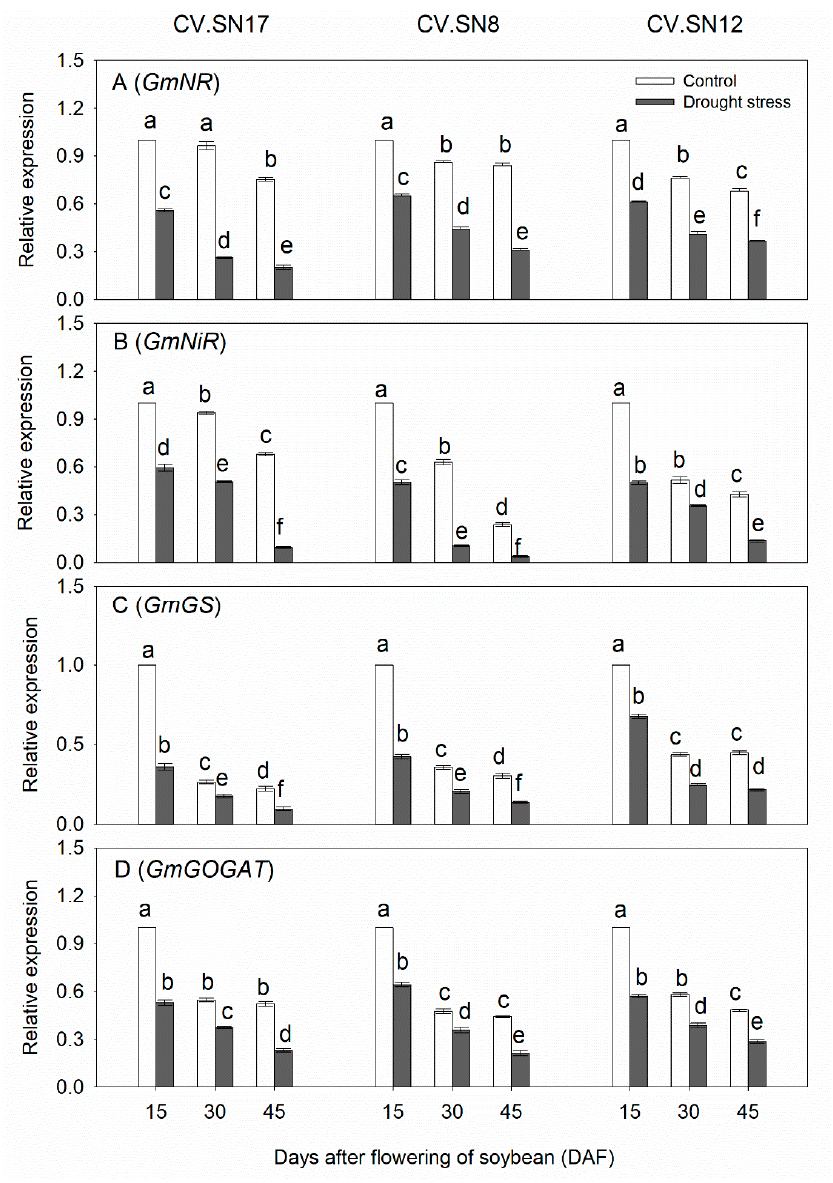
Figure 4. Changes of expression patterns of ( A ) GmNR , ( B ) GmNiR , ( C ) GmGS , and ( D ) GmGOGAT in leaves of CV.SN17, CV.SN8 and CV.SN12 under control and drought stress conditions. Data show the means ± standard deviation of three independent samples. Di ff erent letters above vertical bars indicate significant di ff erences between means at a p < 0.05 level.